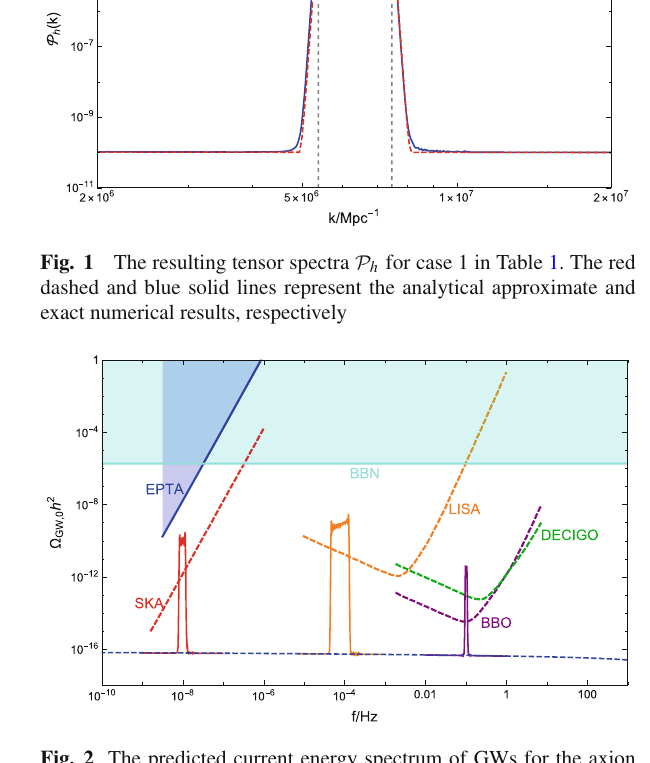
Fig. 2 The predicted current energy spectrum of GWs for the axion monodromy inflation model with the gravitational Chern–Simons term. The red/orange/purple solid lines correspond to case 1, 2 and 3 of Table 1, respectively. The blue dashed line represent the standard GW energy spectrum predicted by the axion monodromy inflation model. The other dashed lines are the expected sensitivity curve of the future gravitational-wave projects summarized in [55]. The shaded regions represent the present existing constraints on GWs